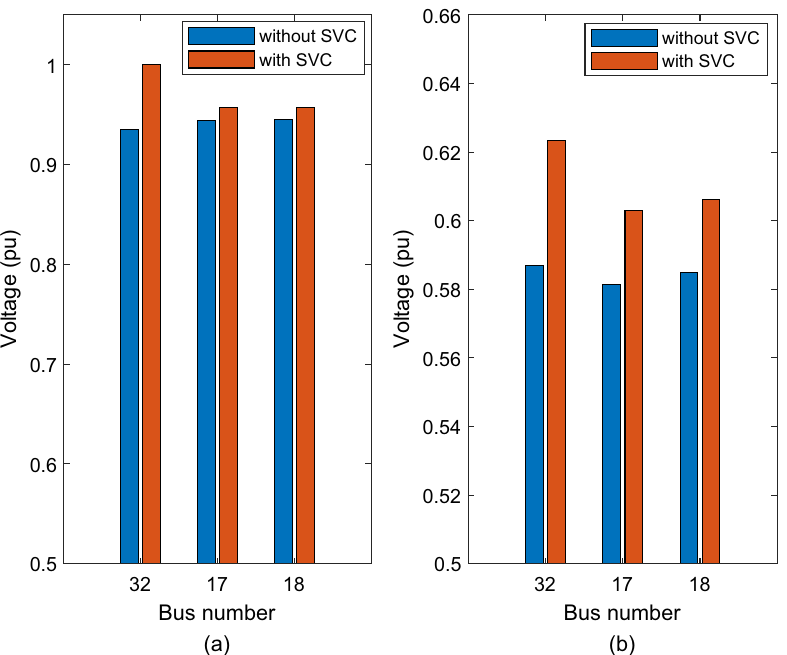
Figure 7. Voltage improvement after adding SVC at bus 32 ( a ) nominal load ( b ) heavy load.